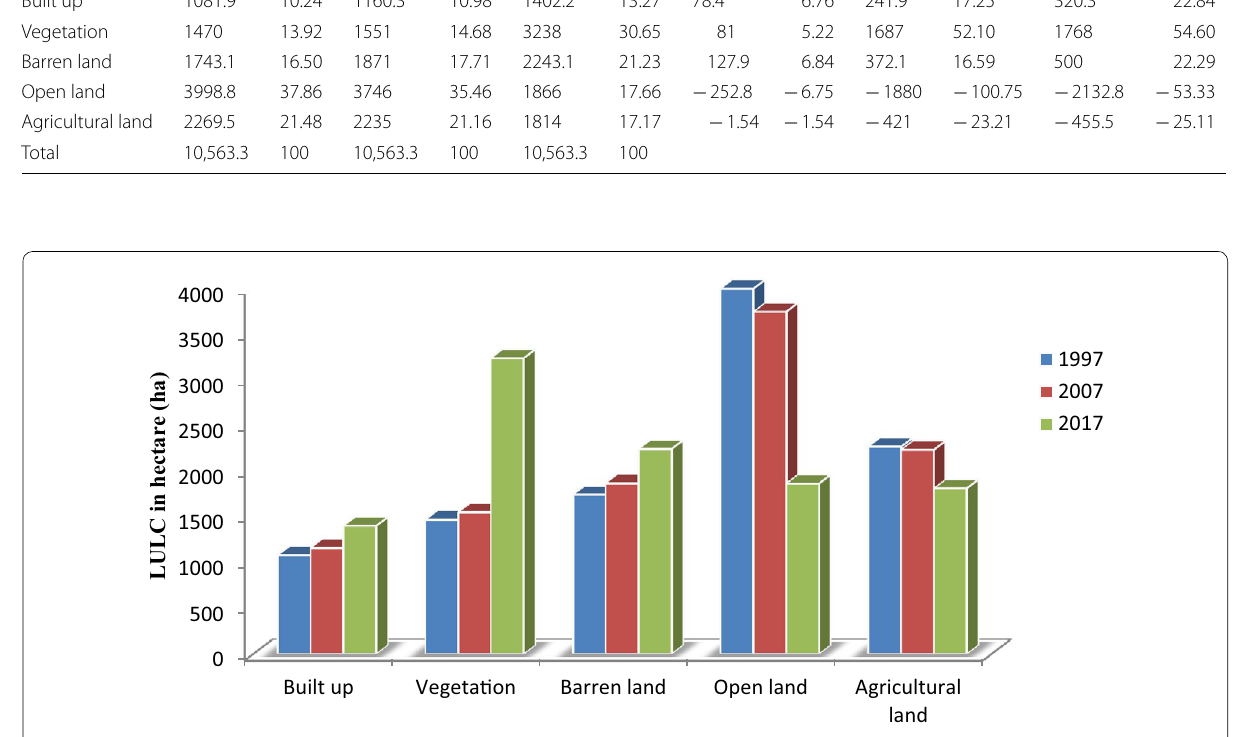
Fig. 3 Jimma city LULC in 1997, 2007, and